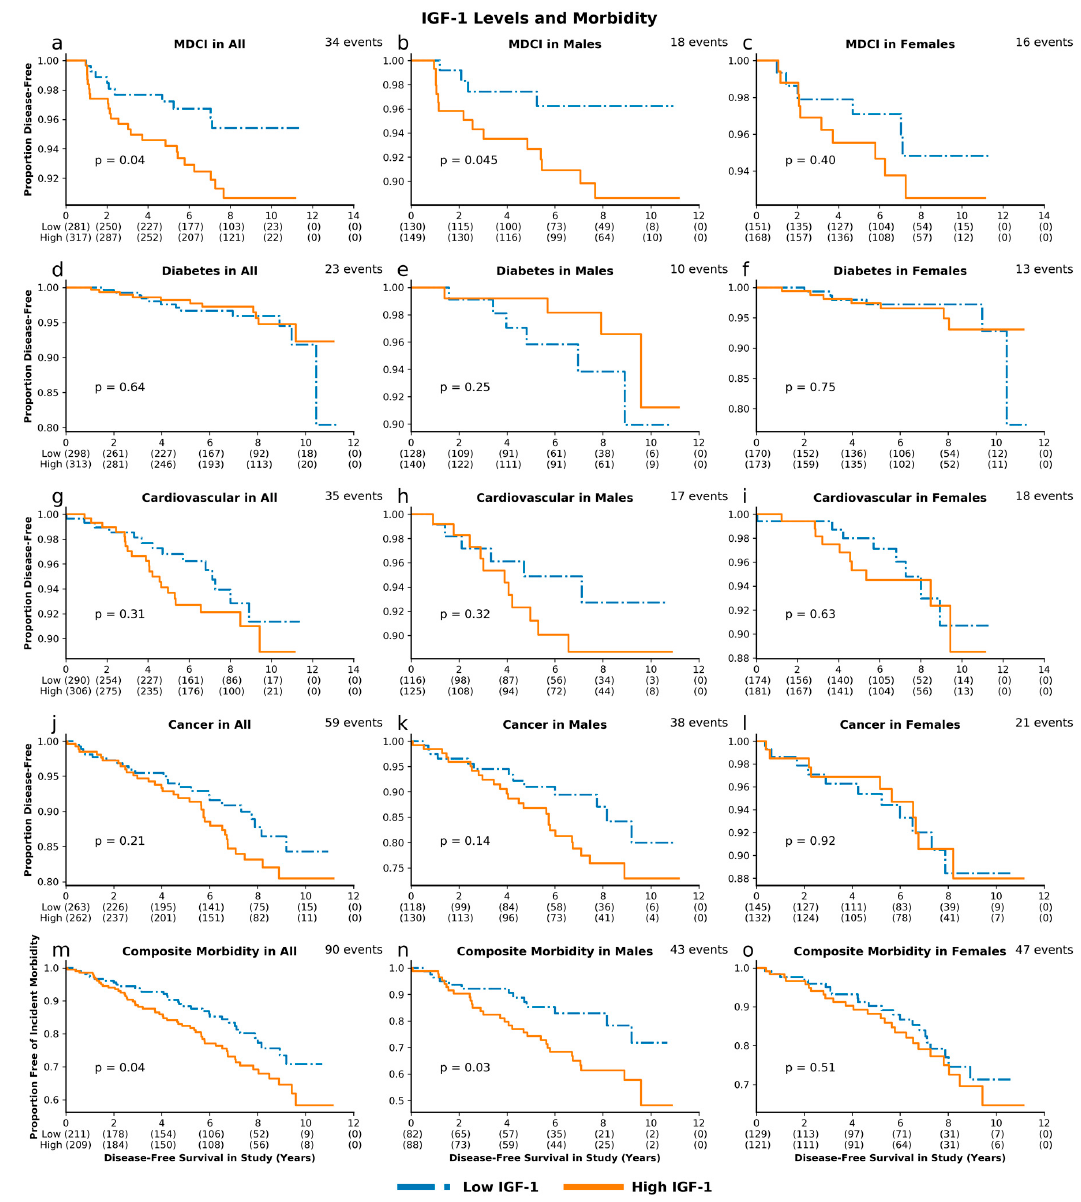
Figure 3. IGF-1 levels and morbidity. Unadjusted survival curves for multiple-domain cognitive impairment (MDCI) ( a . combined cohort; b . males; c . females), diabetes ( d – f ), cardiovascular disease ( g – i ), cancer ( j – l ), and composite incident morbidity ( m – o ) in individuals with high and low levels of IGF-1.